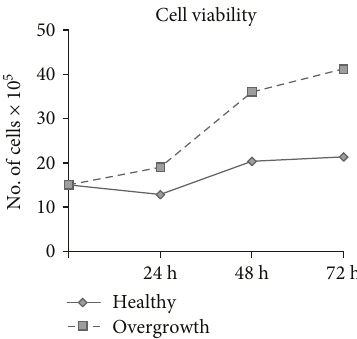
Figure 4: Cell proliferation. Growth curves showing cell viability in fi broblasts from healthy and overgrown gingivae after 24, 48, and 72